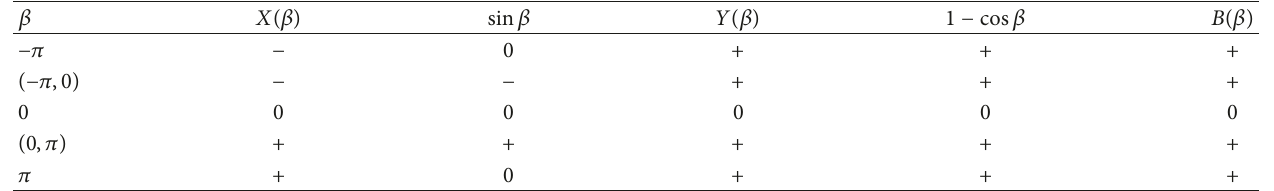
Table 2: Signs of the terms of 𝐵(𝛽)